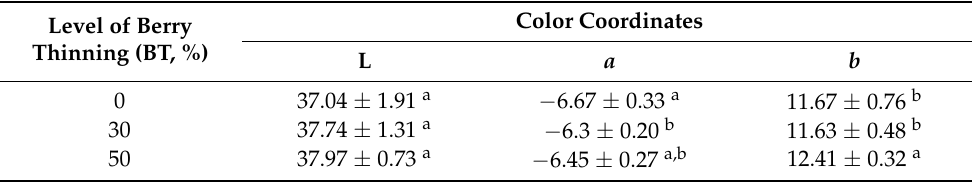
Table 1. Effects of berry thinning on the skin color indices of Shine Muscat grapes.